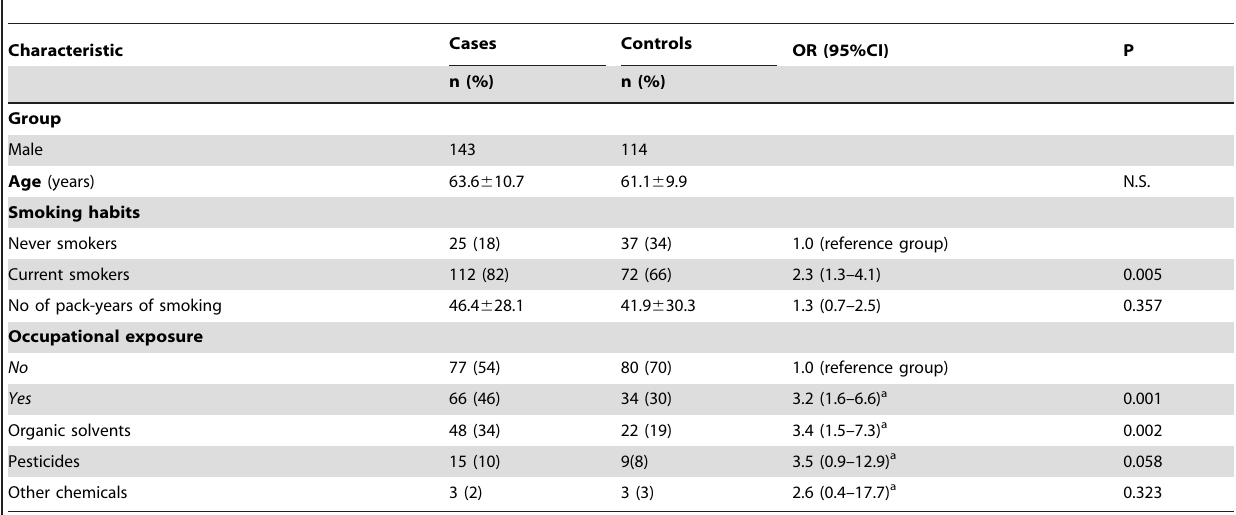
Table 1. Selected characteristics of male patients with bladder cancer and